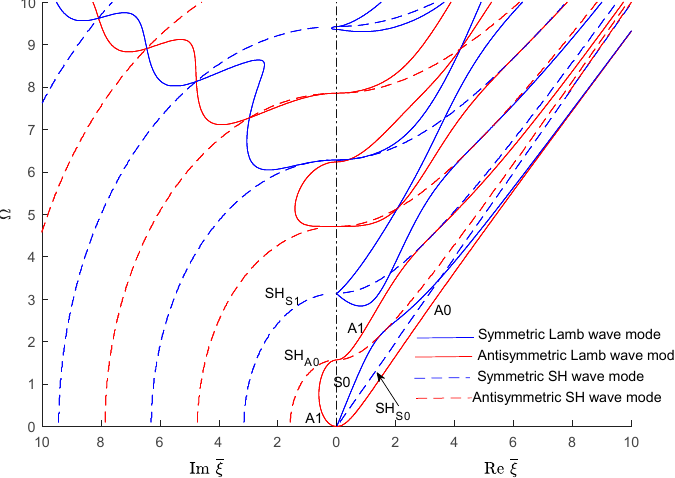
Figure 7. Real and imaginary wavenumber roots (combined Lamb and SH wave plot) for an isotropic